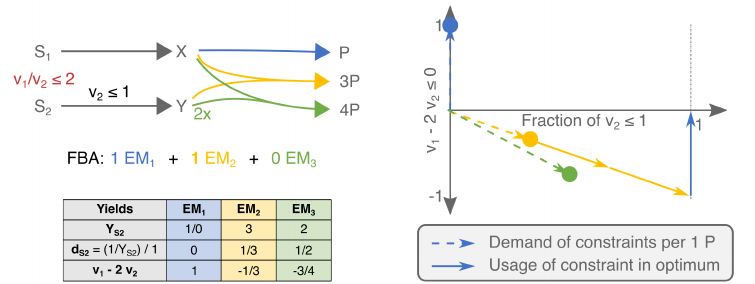
Figure A2. Our visual analysis of FBA solutions using cost vectors even works when constraints on ratios of reaction rates are used. The last toy network of Figure 1 is taken, and a constraint is added on the ratio of the uptake rates ( v 1 / v 2 ≤ 2). By rewriting this as v 1 − 2 v 2 ≤ 0, this becomes a linear constraint for which we can calculate the cost vectors: the second coordinate now captures the deviation from the imposed ratio that using this EM induces. A positive value indicates that the ratio of reaction rates used in this EM is too high, and vice versa. Where in the original optimization problem, the sum of cost vectors could not exceed the unit box, this sum may now not exceed the horizontal